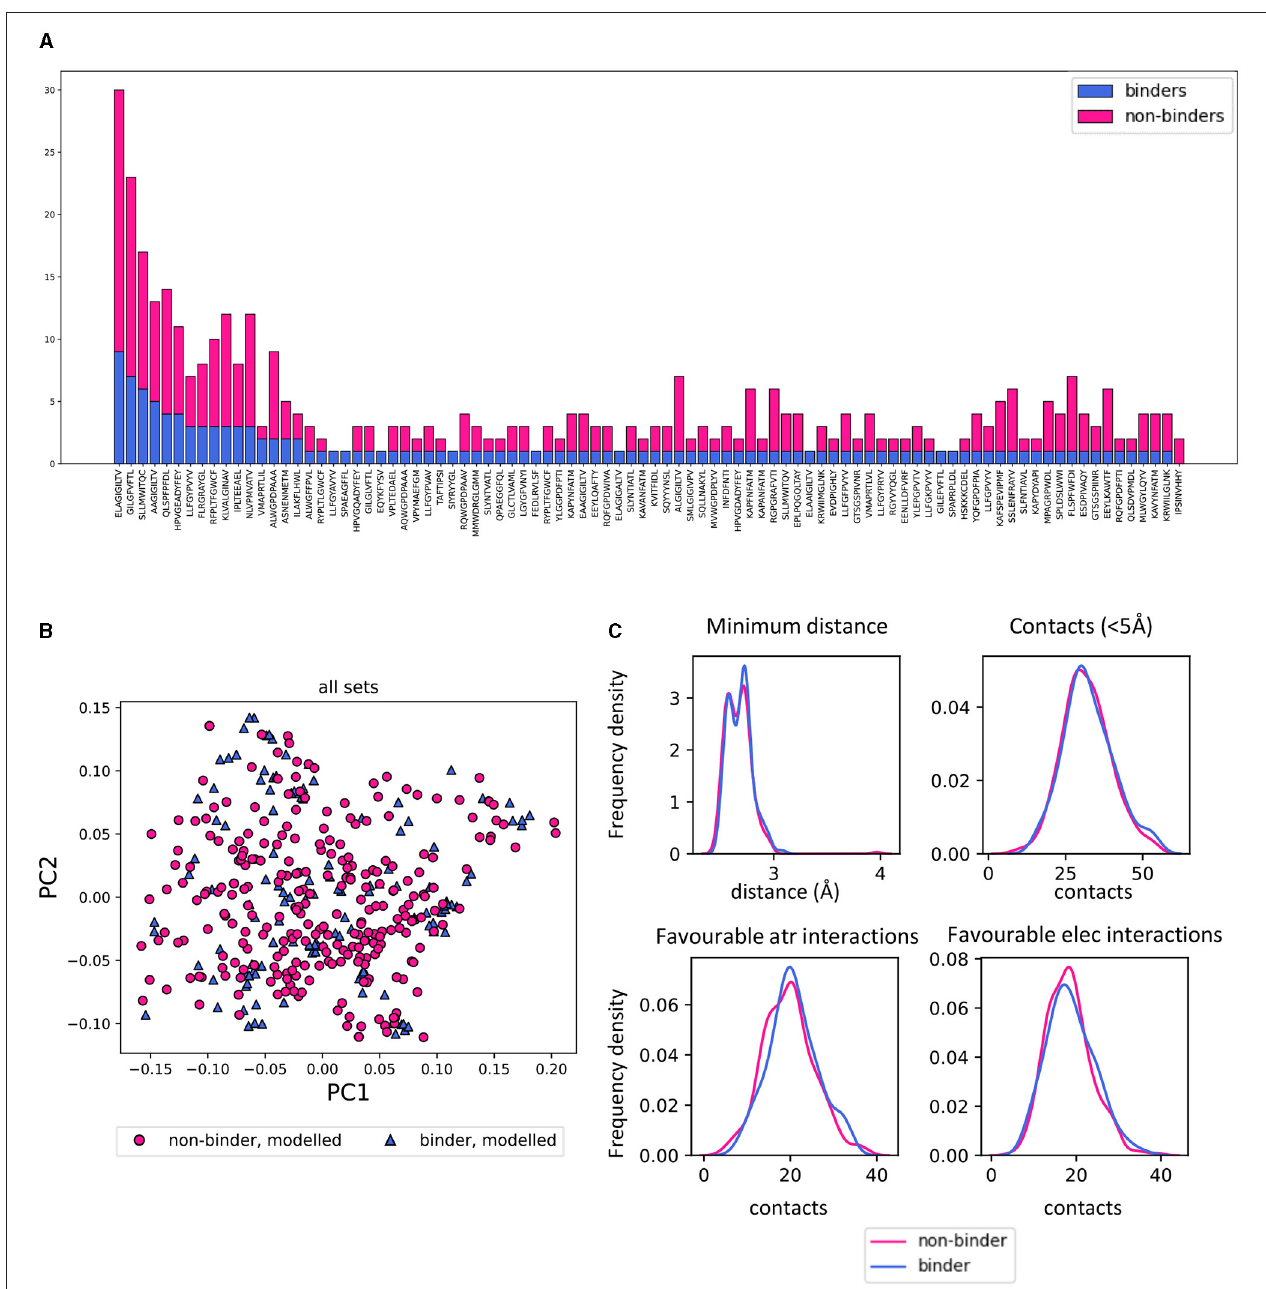
FIGURE 5 | Homology modelled binding and non-binding TCR-pMHC complexes can not be discriminated by PCA. (A) Summary of the number of STCRDab derived binding and non-binding structures which were modelled. For each peptide in the set, the barplot shows the number of models of binding and non-binding TCRs (blue and magenta, respectively). (B) PCA of all sets combined showing no separation between binding and non-binding TCR/pMHC homology models. The PCAs for each feature set separately are in Supplementary Figure 4 . (C) Frequency distributions of 4 characteristics of the TCR-pMHC complexes comparing the distribution between binding and non-binding models. Minimum distance: minimum distance between TCR and peptide; Contacts: number of TCR-peptide residue pairs that are < 5Å apart; Favourable atr/elec interactions: number of favourable (energy < 0) interactions between TCR and peptide.